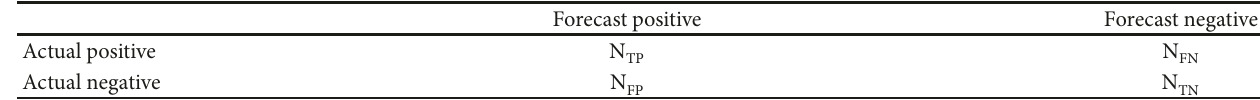
Table 2: Definition of contingency table.